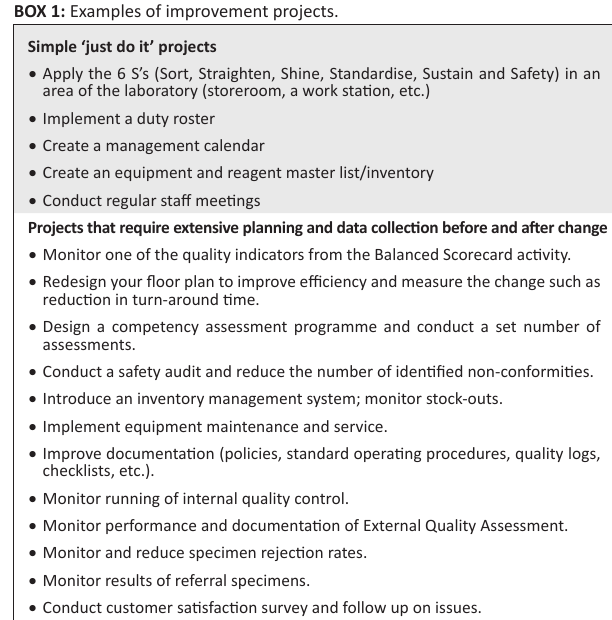
FIGURE 1: Standard SLMTA implementation